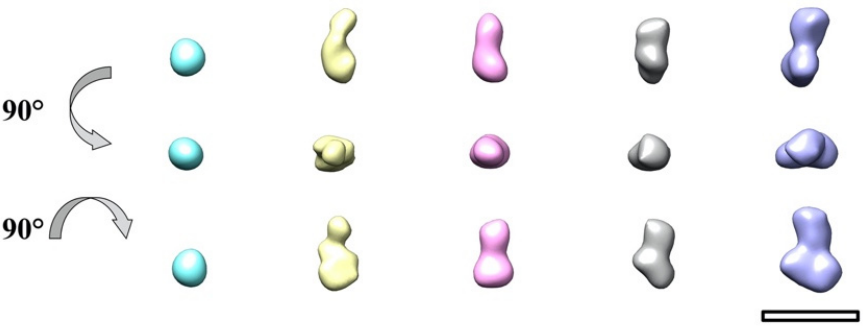
Figure A3. Various projections of iron clusters with a volume less than 4 nm 3 at a threshold of 3 σ divided into 5 3D classes. The classes are arranged in ascending volume (left to right). Scale bar is 5 nm.